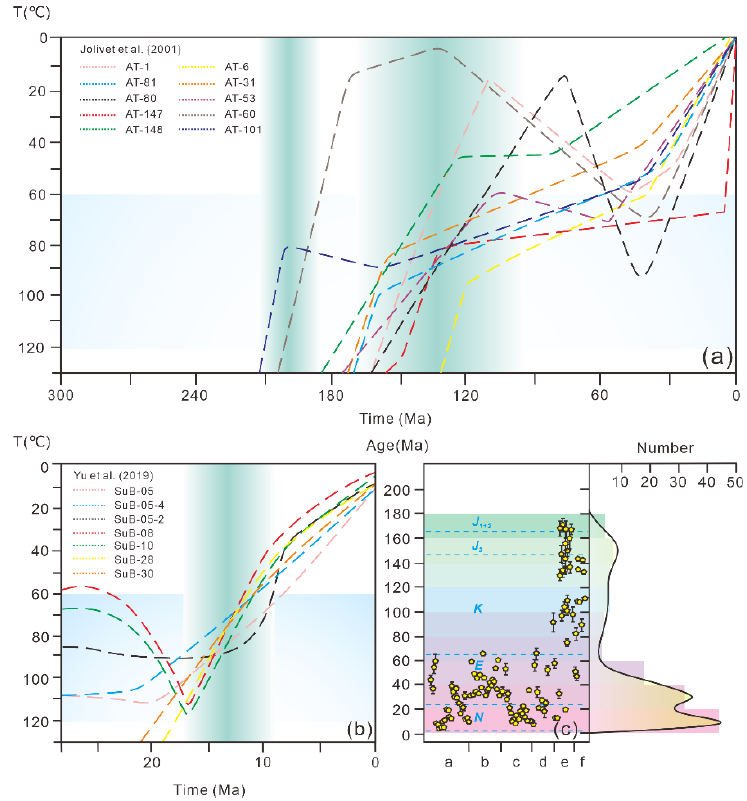
Figure 12. Thermal modeling results and thermochronology dataset from the block along Altyn Fault belt: ( a , b ) compiled from Jolivet et al. [83] and Yu et al. [95], dotted lines indicate the expected model results. ( c ) Fission track analysis of apatites and zircons in the area of Altyn Fault belt; thermochronology data are from a. Chen et al. [96], b. Sun et al. [97], c. Wan et al. [98], d. Wang et al. [99] and Wang et al. [100], e. Jolivet et al. [83], f. Peng [101]. Apatites and zircons used in fission track analysis were fully or partially thermally